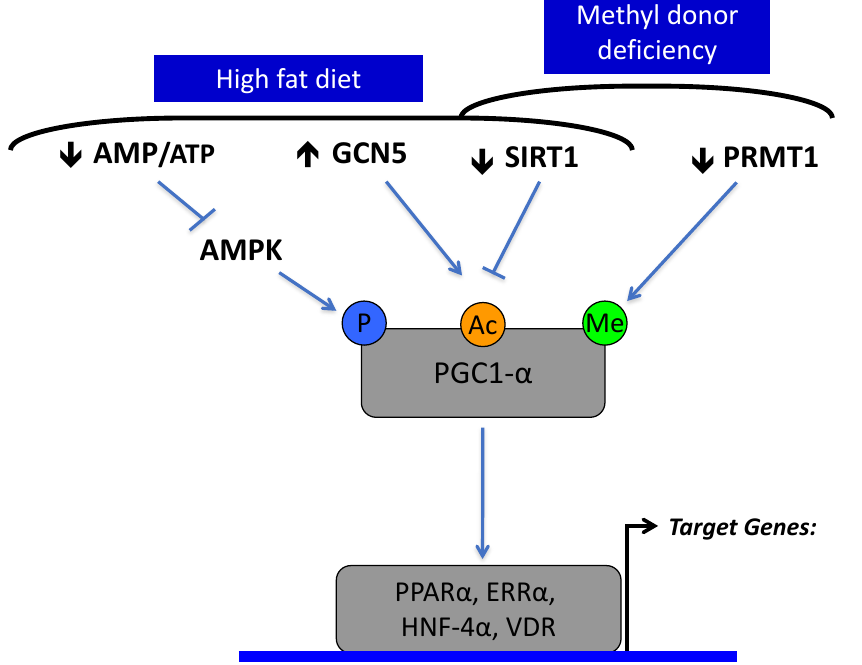
Figure 2. The decreased expression and activity of Sirtuin1 is a common molecular hallmark in a high fat diet and methyl donor deficiency (MDD). Sirtuin1 targets the acetylation of peroxisome proliferator-activated receptor- γ coactivator-1 α (PGC1 α ) and has a complementary role with GCN5 acetylase, AMP kinase and protein arginine methyltransferase (PRMT1) in the regulation of PGC1 α activation of nuclear receptors, including PPAR α , ERR α , HNF-4 α and VDR. PGC1 α is phosphorylated and acetylated under the control of AMP kinase (AMPK), GCN5 acetylase and SIRT1 deacetylase. High fat diet and over nutrition decrease activity of AMP kinase, through high intracellular ATP levels, leading to decreased phosphorylation of PGC-1 α . It produces hyperacetylation of PGC-1 α through increased expression of GCN5 and decreased expression and activity of SIRT1. MDD produces similar e ff ects through decreased SIRT1 and